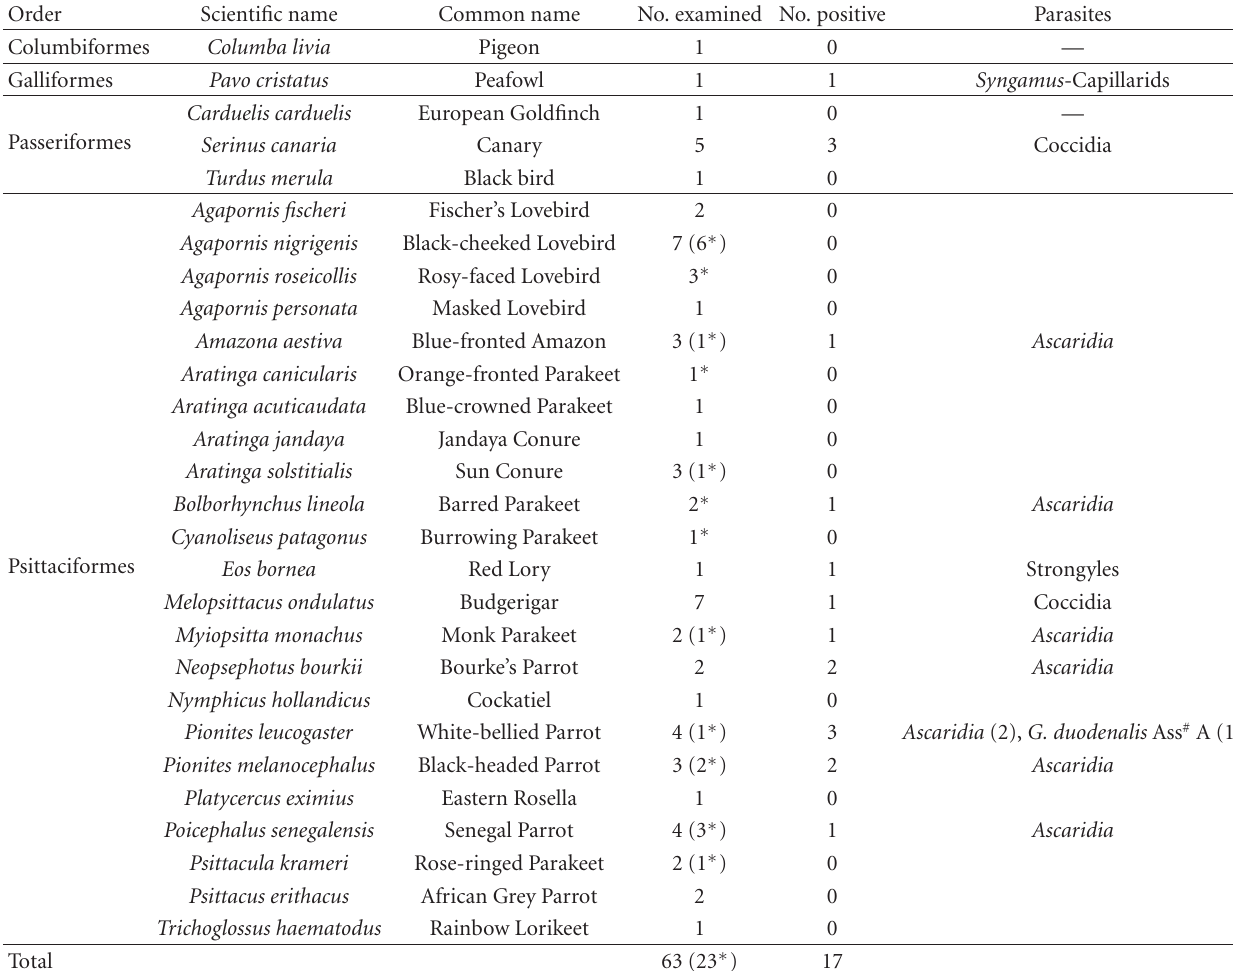
Table 1: Orders, scientific names, common names, numbers examined, positive numbers, and intestinal parasites found in pet birds.